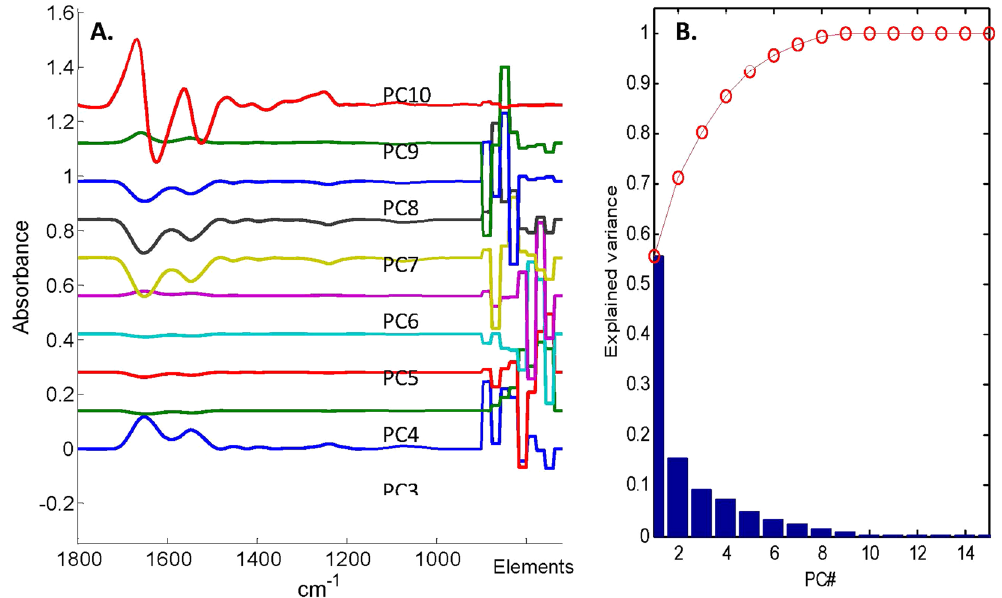
Figure 10. ( A ) PCs 1 to 10 (from bottom to top) obtained after PCA of the data presented in Fig. 8. The mean spectrum has not been subtracted prior to PCA. ( B ) fraction of the variance explained as a function of the number of PCs. The red line reports the cumulative fraction of the variance